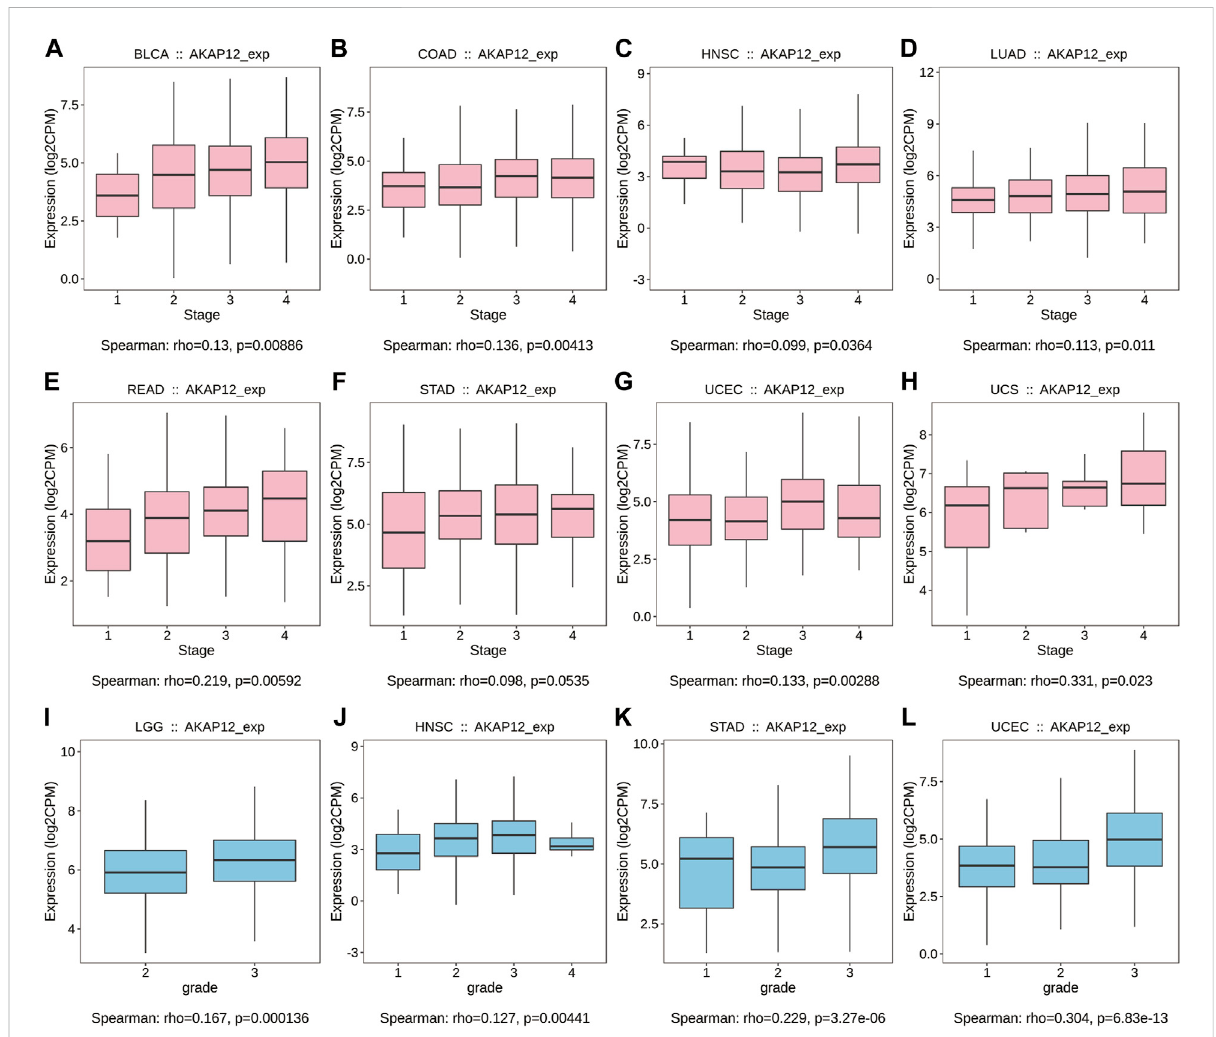
FIGURE 5 CorrelationbetweenAKAP12expressionandstagesaswellasgradesamongvariousTCGAtumorsbasedontheTISIDBdatabase.Correlationof AKAP12withstagesofBLCA (A) ,COAD (B) ,HNSC (C) ,LUAD (D) ,READ (E) ,STAD (F) ,UCEC (G) ,UCS (H) .CorrelationofAKAP12expressionwithgrades of LGG (I) , HNSC (J) , STAD (K) , and UCEC (L)